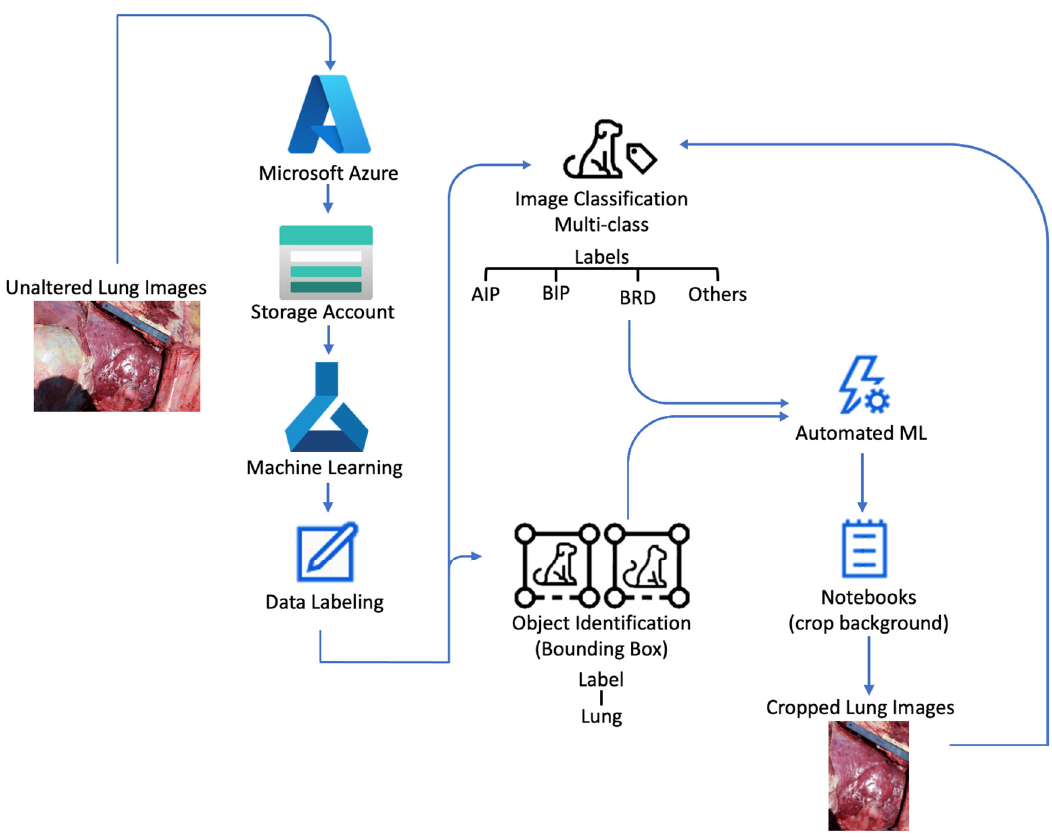
Figure 2. Flow chart depicting intake of unaltered lung images by Microsoft Azure into the storage account. Then, unaltered images were used to perform data labeling within the machine learning studio. Unaltered lung images received labels of acute interstitial pattern (AIP), bronchopneumonia with an interstitial pattern (BIP), bovine respiratory disease (BRD), and other lung diagnoses that were not AIP, BIP, or BRD (undifferentiated). Data tables containing the image and label were exported and fed to the automated ML. In addition, unaltered lung images were labeled using object identification (bounding box) over the lung location. Data tables containing images and binding boxes were fed to automated ML to predict lung location. Then, images were cropped using a notebook code and fed back to image classification to follow the same process as the unaltered lung